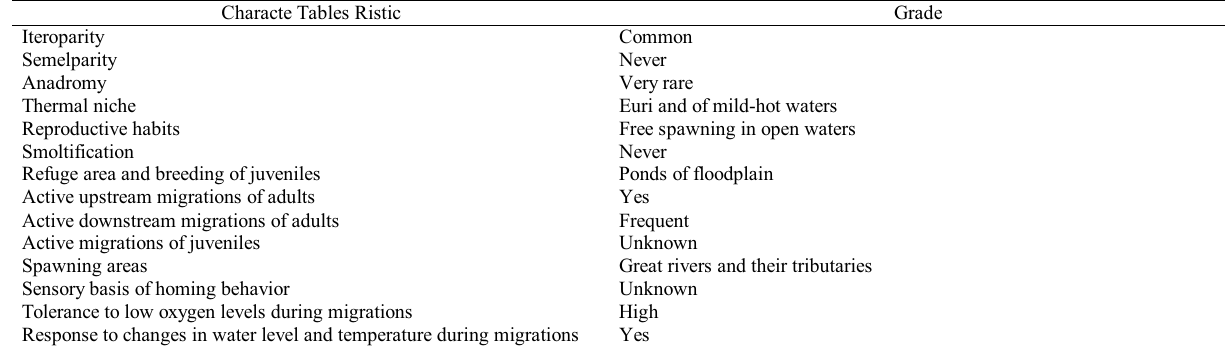
Table 4. Primary characteristics of migratory fish species of the rivers in the La Plata basin (modified from Oldani et al.,